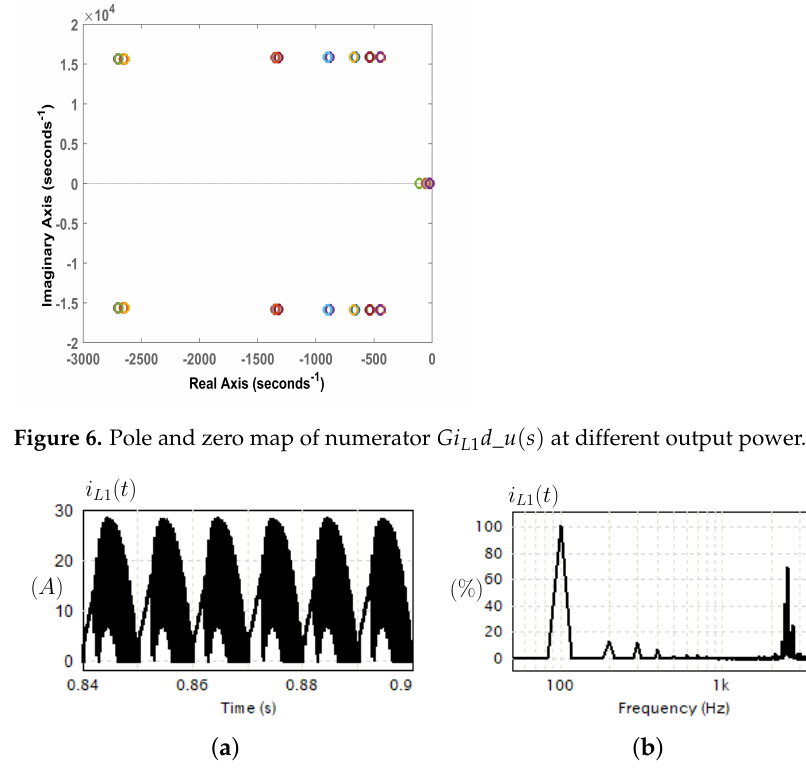
Figure 7. Inductor current i L 1 ( t ) in boost mode without minimum phase condition and its normalized FFT: ( a ) Inductor current waveform i L 1 ( t ) . ( b ) Normalized FFT of Inductor current waveform i L 1 ( t )